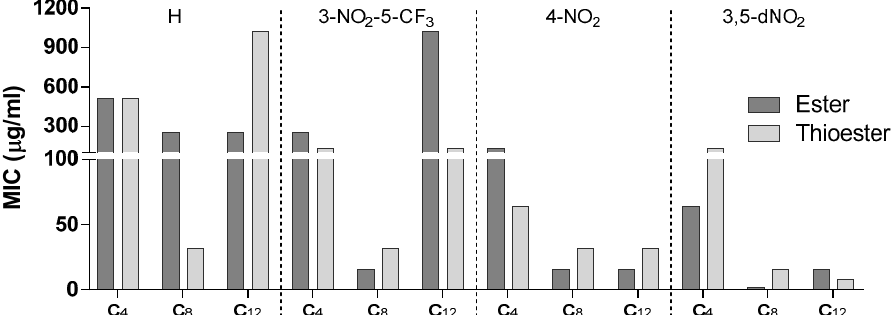
Figure 3. Comparison of the MIC of the esters and corresponding thioesters against M. tuberculosis. Each series has a different electron-withdrawing substituent in the aromatic ring and consists of the butyl (C4), octyl (C8), and dodecyl (C12) esters and corresponding thioesters. Aromatic substituents: hydrogen (H), 3-nitro-5-trifluoromethyl (3-NO 2 -5-CF 3 ), 4-nitro (4-NO 2 ), and 3,5-dinitro (3,5-NO 2 ).